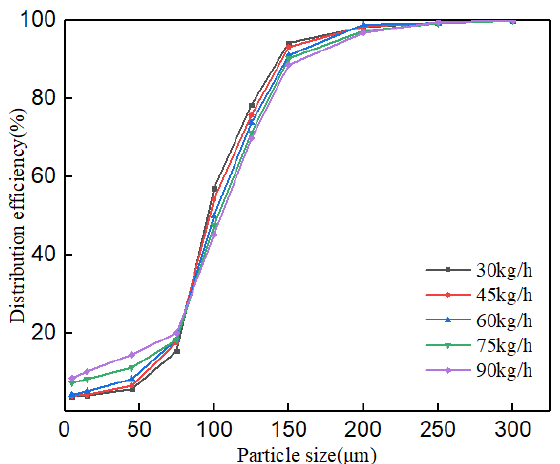
Table 5. Effect of the feeding speed on cumulative particle size content.